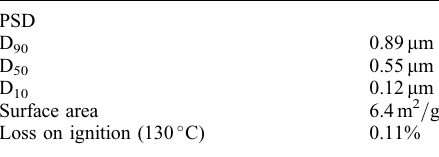
TABLE II Typical Powder Properties of RDAD163N.